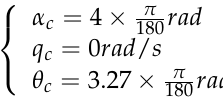
q . q . ( c ) Tracking curve of the pitch derivative . ( c ) Tracking curve of the pitch derivative .  α . ( e ) Tracking curve of the track inclination µ . ( e ) Tracking curve of the track inclination μ.